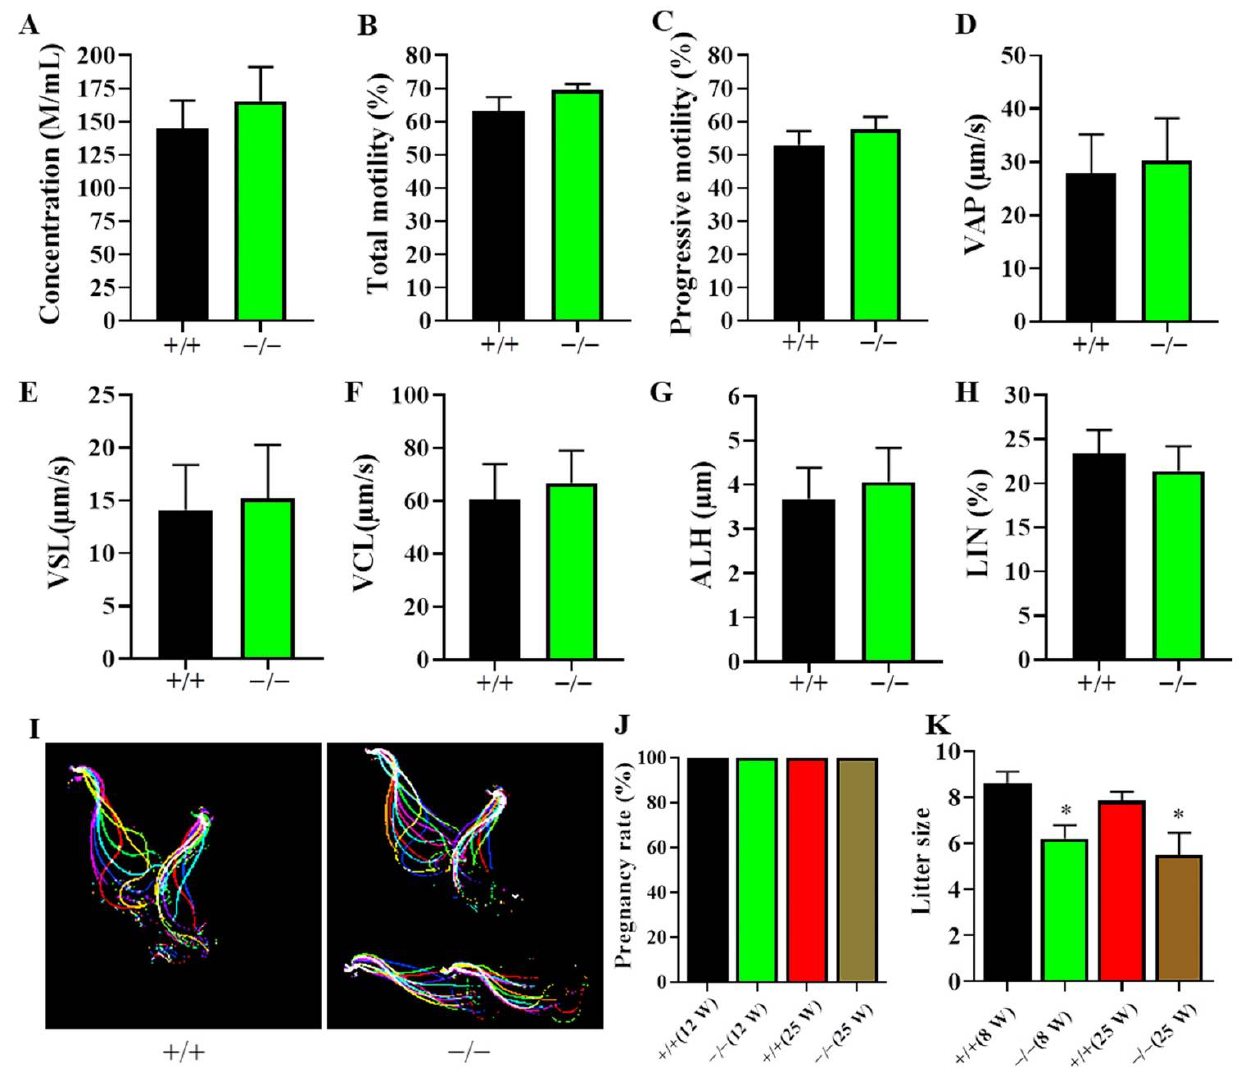
Figure 5. Evaluation of sperm parameters and male fertility in knockout (KO) mice. Sperm were collected from caudal epididymis and measured on a computer assisted sperm analysis system. ( A ) Sperm concentration, ( B ) total motility, ( C ) progressive motility, ( D ) VAP (average path velocity), ( E ) VSL (straight-line velocity), ( F ) VCL (curvilinear velocity), ( G ) ALH (amplitude of lateral head displacement), and ( H ) LIN (linearity) were recorded, respectively. ( I ) The flagellar waveform of WT and O22Rik KO mice. The sperm head was fixed in the dish, and two cycles of sperm tail swing were recorded at a speed of 200 fps, and tracks were superimposed with different colors by FIJI software. ( J ) Pregnancy rates and ( K ) litter sizes were calculated in mating cages (male: female = 1:2) comparing 8- and 25-week-(W)-old male O22Rik KO and WT mice over 3 months. Data are the mean ± SEM ( n = 5). * p < 0.05 compared with WT mice.